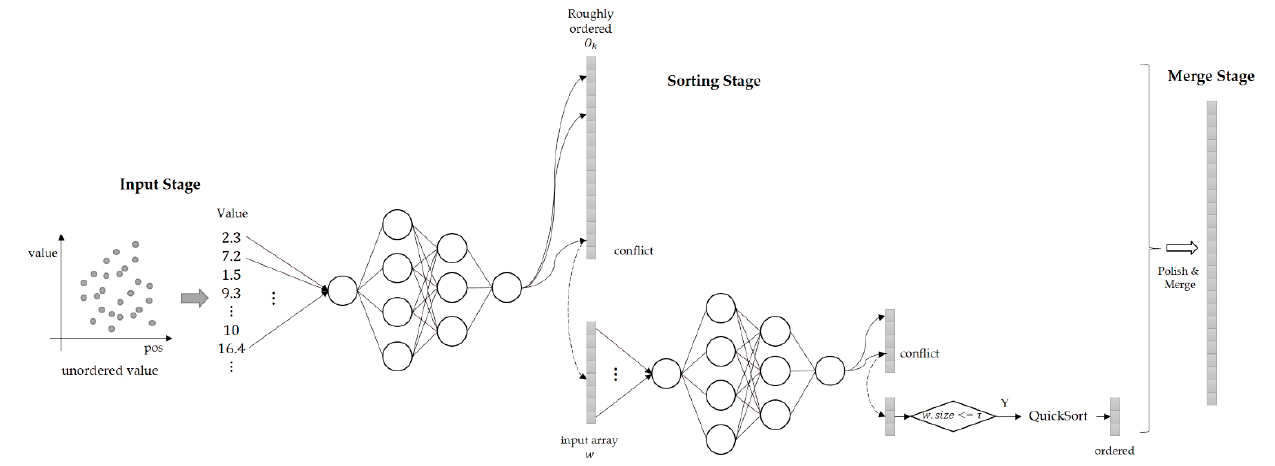
Figure 7. NN-Sort (Neural Network Sort)